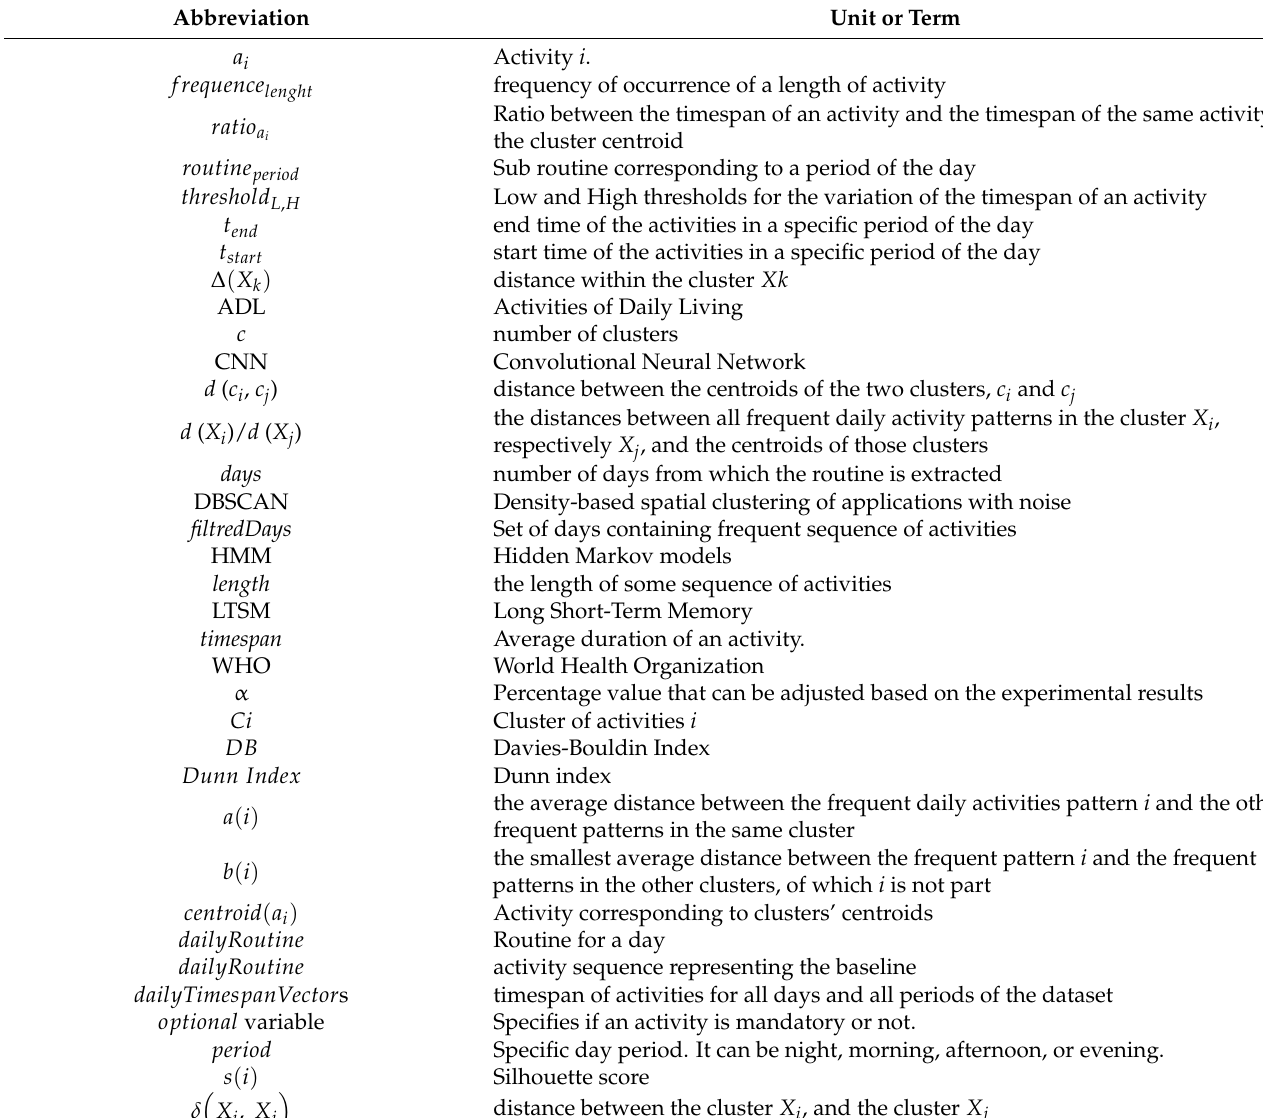
Table 1. Abbreviations and letter